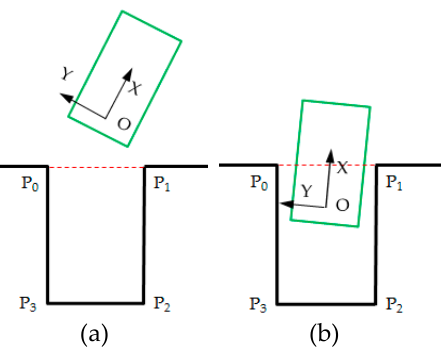
Figure 7. Different parking stages. ( a )The rear axle center of the vehicle is outside the outer line of the parking slot. ( b ) The rear axle center of the vehicle crosses the outer line of the parking slot.